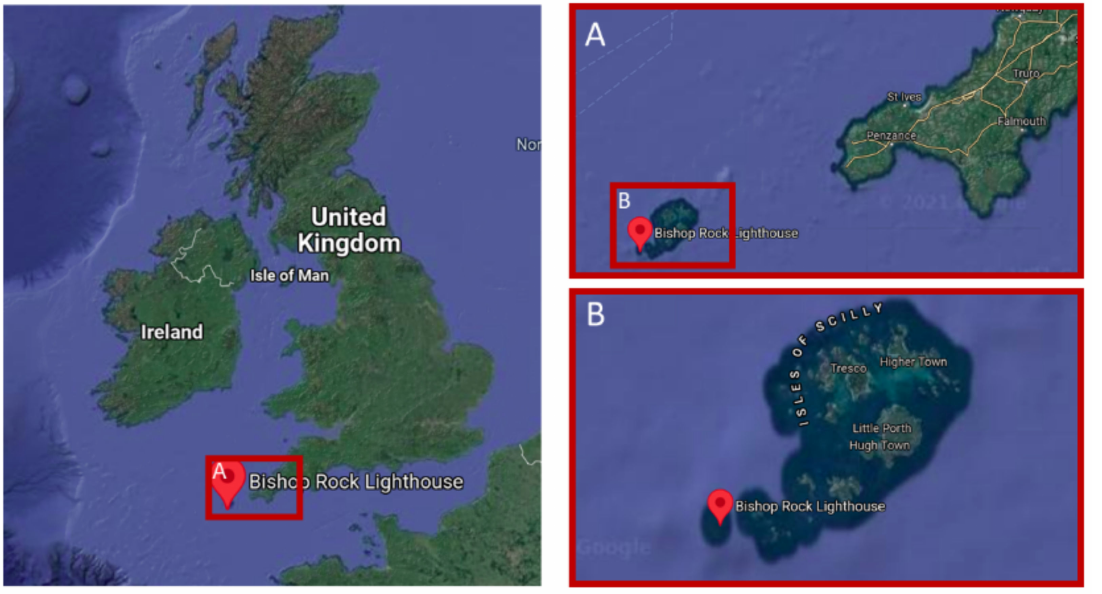
Figure 1. ( Left ): The location of Bishop Rock lighthouse; ( Right and top ): Magnified view of “A” shown on the left figure; ( Right and bottom ): Magnified view of “B” shown on the right and top figure [Google Map].